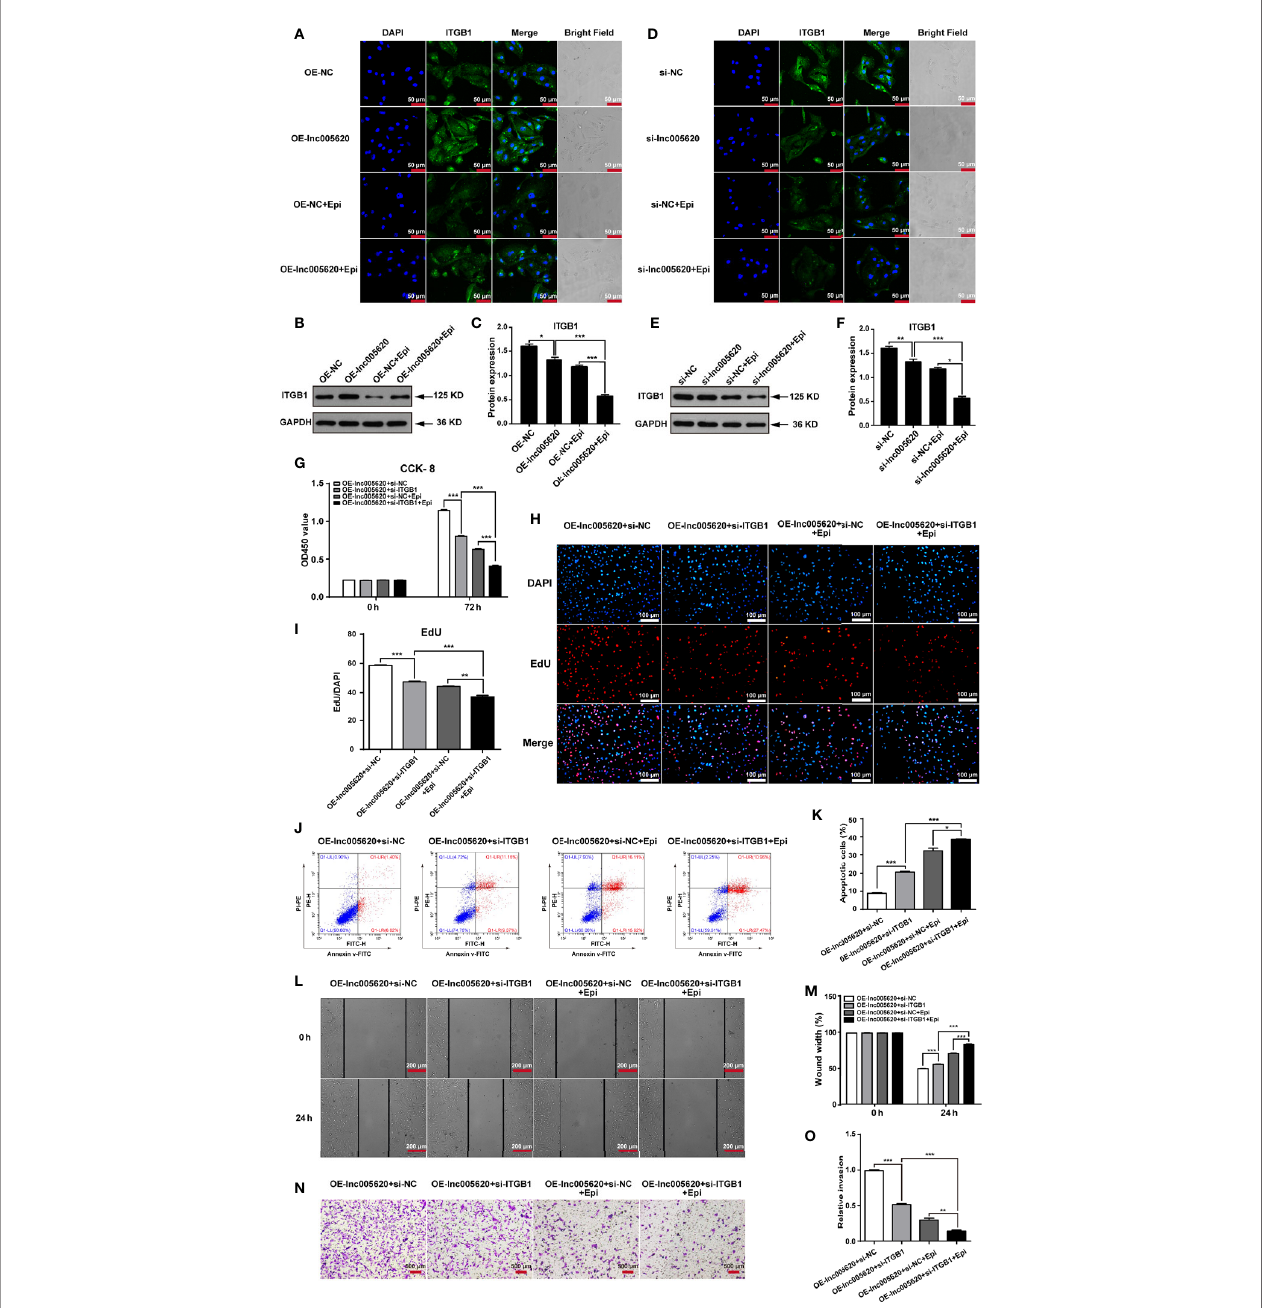
FIGURE 6 | ITGB1 is a downstream target of lnc005620 that functions in the epirubicin resistance of MDA-MB-231 cells. lnc005620 was overexpressed in native MDA-MB-231 cells or knocked down in epirubicin-resistant MDA-MB-231 cells, and treated with or without 12.5 ng/ml epirubicin for 48 h (A – F) . (A, D) Immuno fl uorescence staining of ITGB1. Blue: DAPI for nuclei, green: ITGB1. Scale bars: 50 m m. (B, E) Western blotting of ITGB1. (C, F) . Quantitative analysis of ITGB1 protein expression. lnc005620 was overexpressed and ITGB1 was knocked down simultaneously in native MDA-MB-231 cells treated with or without 12.5 ng/ml epirubicin (G – O) . (G) Cell proliferation analysis by CCK-8 assay. (H) Cell proliferation analysis by EdU assay. DAPI for nuclei. Scale bars: 100 m m. (I) Quantitative analysis of EdU assay. (J) Flow cytometry analysis of cell apoptosis. (K) Quantitative analysis of apoptotic cell percentages. (L) Cell migration analysis by wound healing assay. Scale bars: 200 m m. (M) Quantitative analysis of cell migration. (N) Cell invasion analysis by Transwell assay. Scale bars: 500 m m. (O) Quantitative analysis of cell invasion. OE-lnc005620+si-NC, overexpression of lnc005620 plus negative control; OE-lnc005620+si-ITGB1, overexpression of lnc005620 plus siRNA against ITGB1; OE-lnc005620+si-NC+Epi, overexpression of lnc005620 plus negative control and exposure to epirubicin; OE-lnc005620+si- ITGB1+Epi, overexpression of lnc005620 plus siRNA against ITGB1 and exposure to epirubicin. n = 3, Data are represented as the mean ± SD, * P < 0.05, ** P < 0.01, *** P <